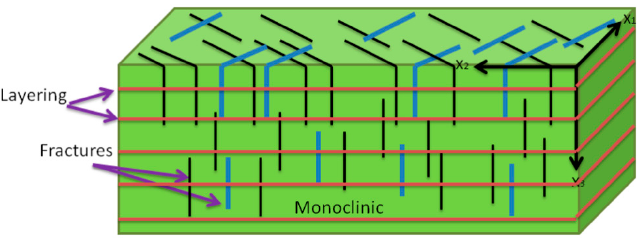
Figure1. Figure 1. Two non-orthogonal vertical fracture sets with a vertical transverse isotropic (VTI) background.